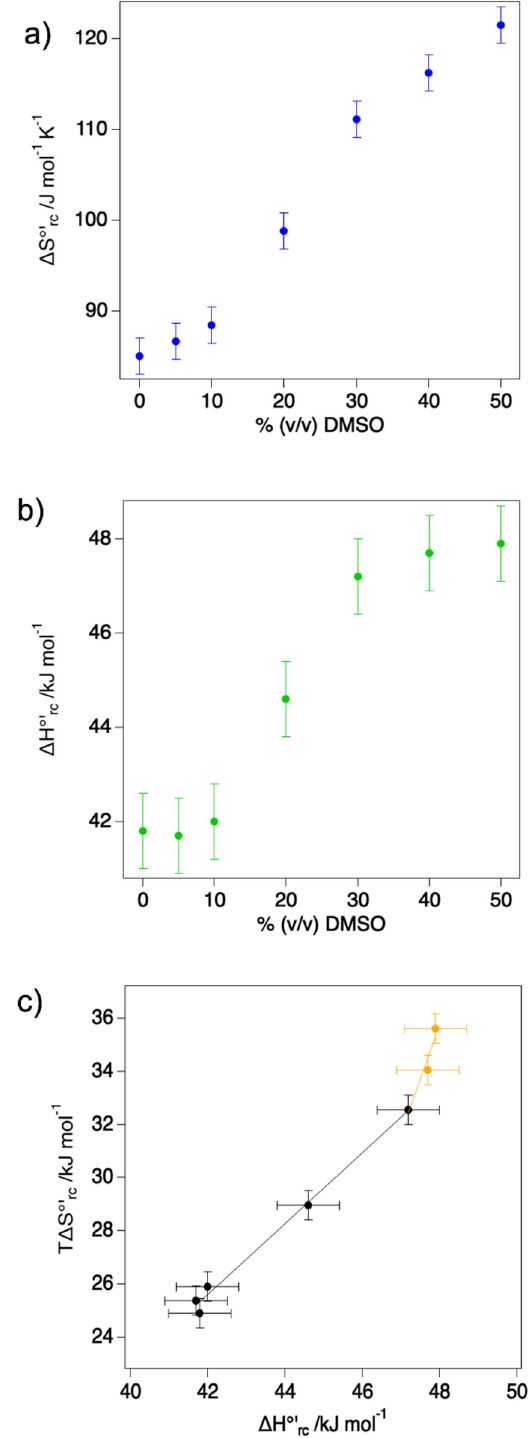
Figure 4. Dependence of Δ S°’ rc ( a ) and Δ H°’ rc ( b ) on the %DMSO for M80A mutant of yeast cytc. ( c ) Enthalpy-entropy compensation plot. The temperature considered to calculate the entropic component was 293 K. The black and orange lines are least-squares fits to the data points for %DMSO ≤ 30% and %DMSO ≥ 30%, respectively.